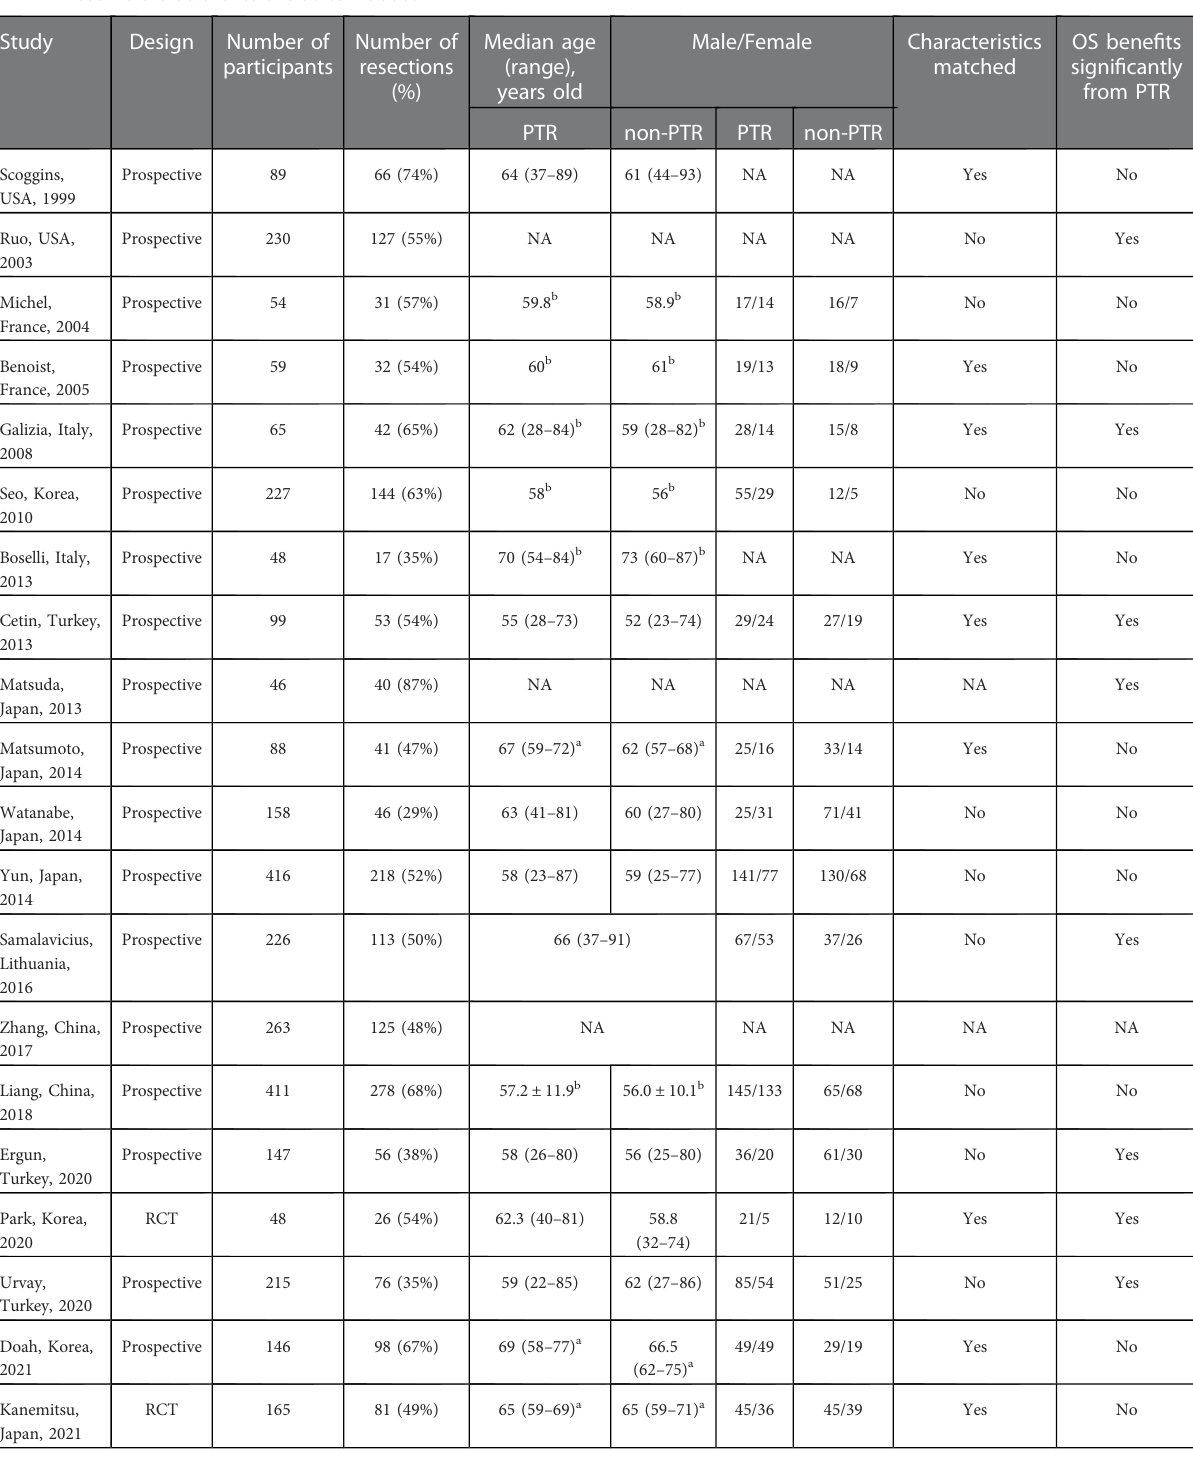
TABLE 1 Baseline characteristics of studies